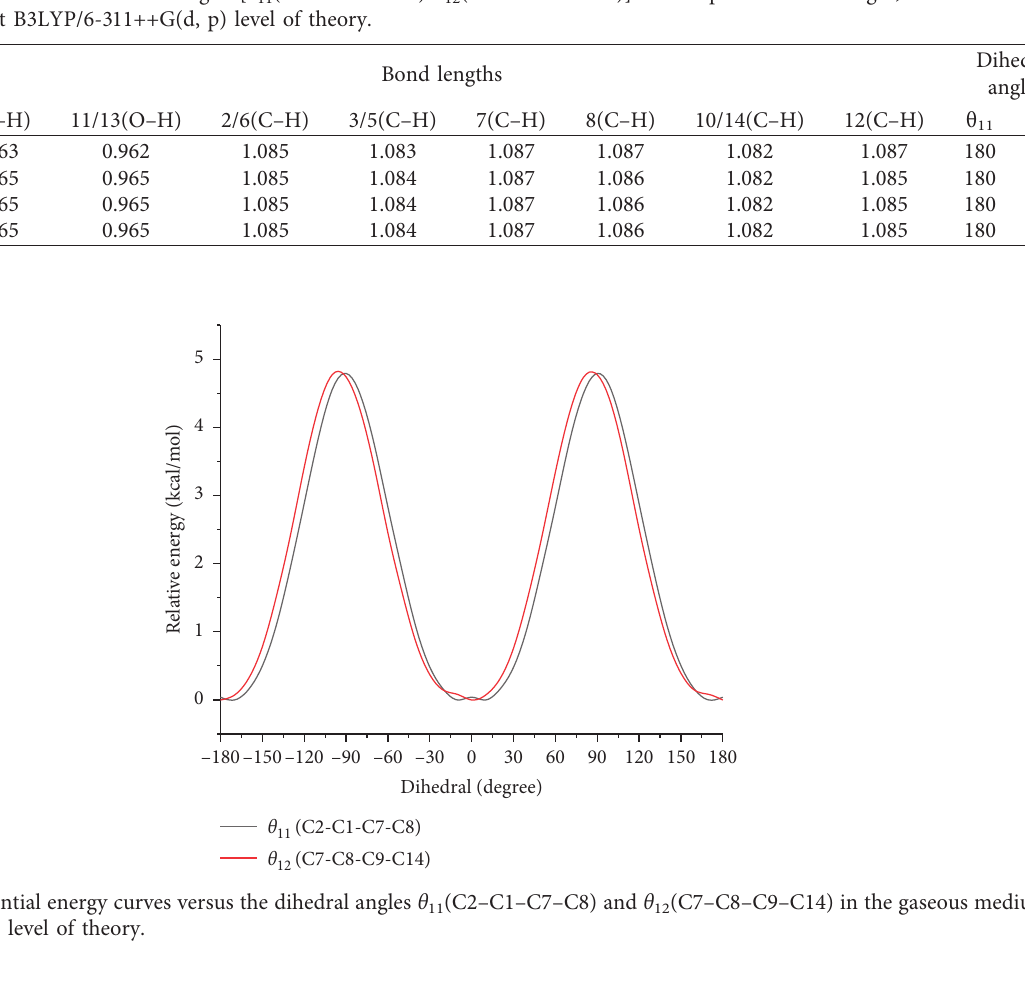
Figure 1: Resveratrol and its proposal radical Table 1: Bond distances and dihedral angles [ θ 11 (C2–C1–C7–C8)/ θ 12 (C7–C8–C9–C14)] of the optimized RSV in gas, acetone methanol,